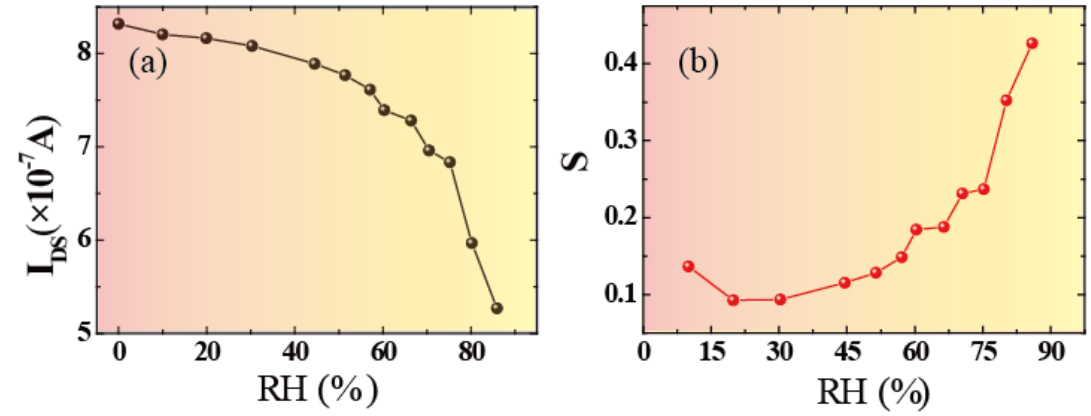
Figure 4. Relative humidity effect on the device performance. ( a ) Channel currents ( I DS ) with the relationship of RH ( b ) The variation in sensitivity of the device for different RH values.